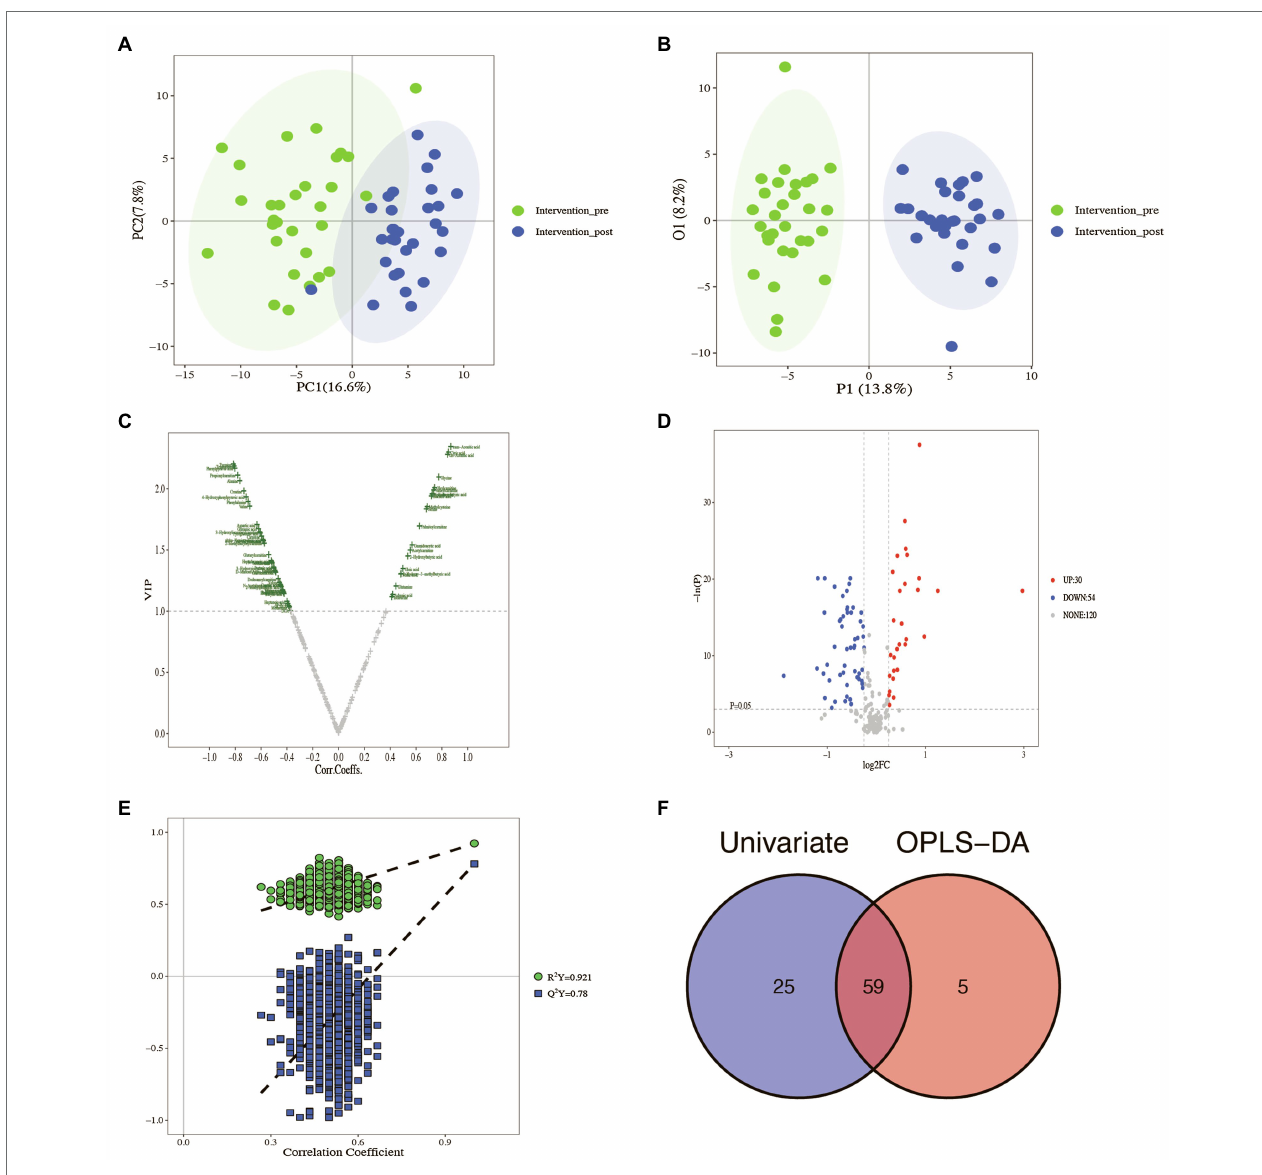
FIGURE 1 | Identification of the potential metabolites between baseline and post-intervention. (A) PCA plot; (B) OPLS-DA plot; (C) volcano plot of OPLS-DA model; (D) volcano plot of univariate statistics; (E) OPLS-DA permutation plot; (F) Venn plot of differential